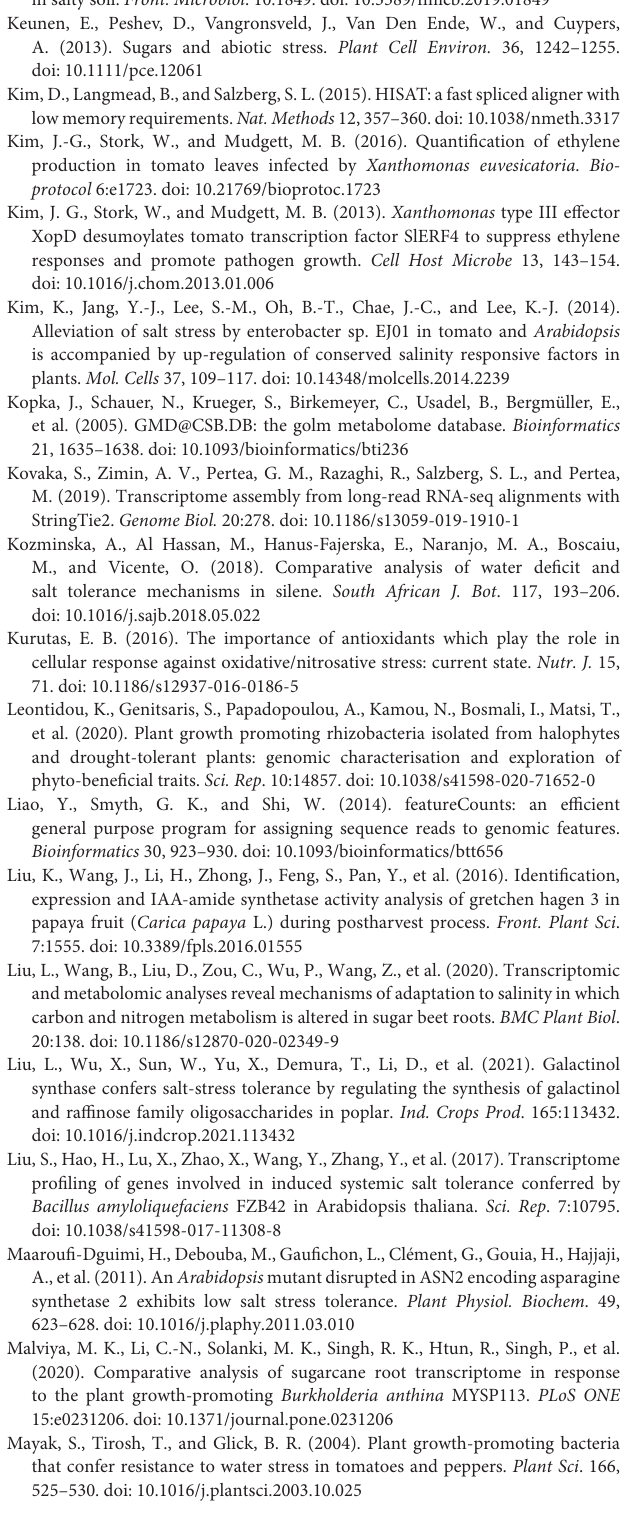
protocol 6:e1723. doi: 10.21769/bioprotoc.1723 Kim, J. G., Stork, W., and Mudgett, M. B. (2013). Xanthomonas type III